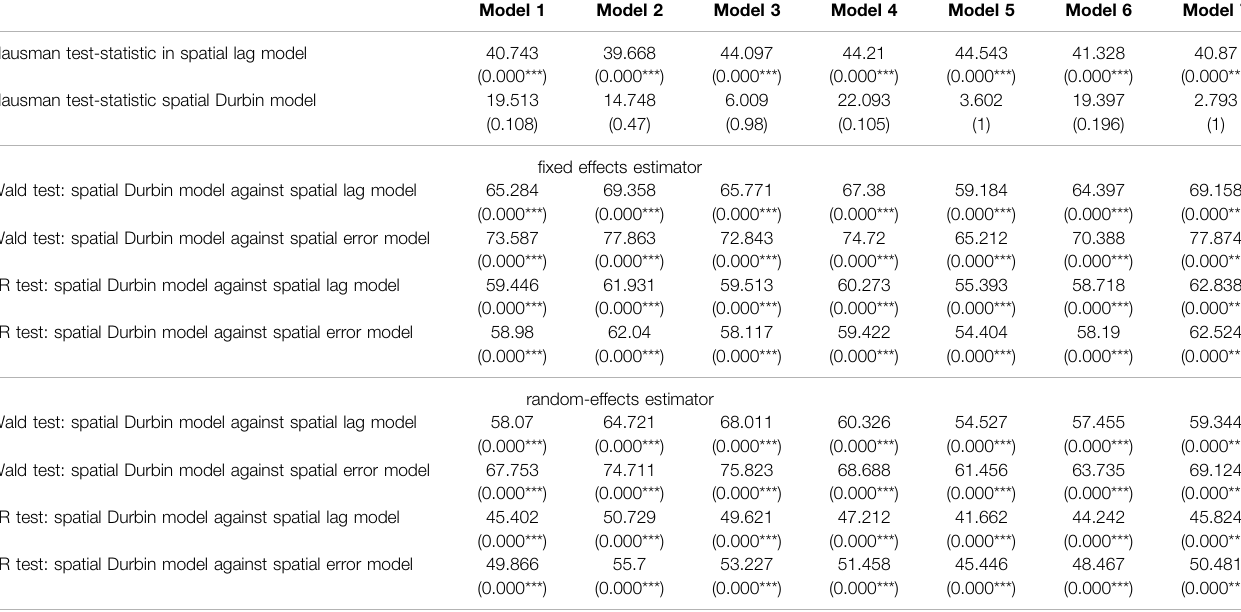
TABLE 4 | The spatial durbin model and hausman test